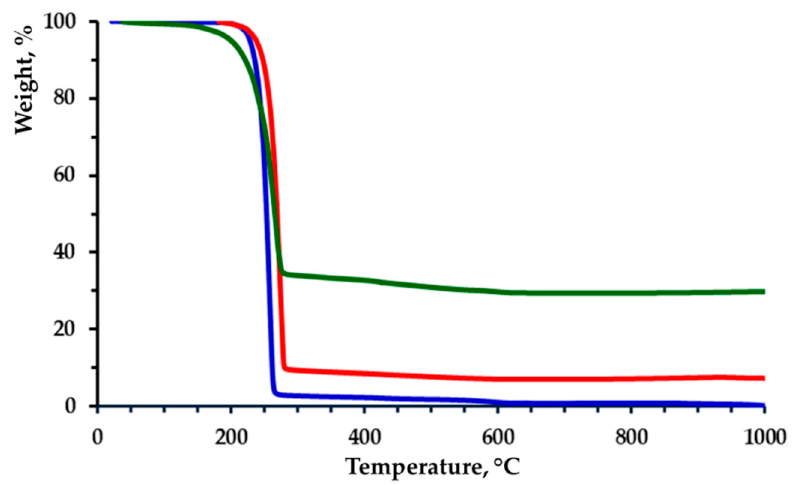
Figure 7. TGA thermograms of fibrous PHB (blue line), TiO 2 - in -PHB (green line) and TiO 2 - on -PHB (red line) materials.